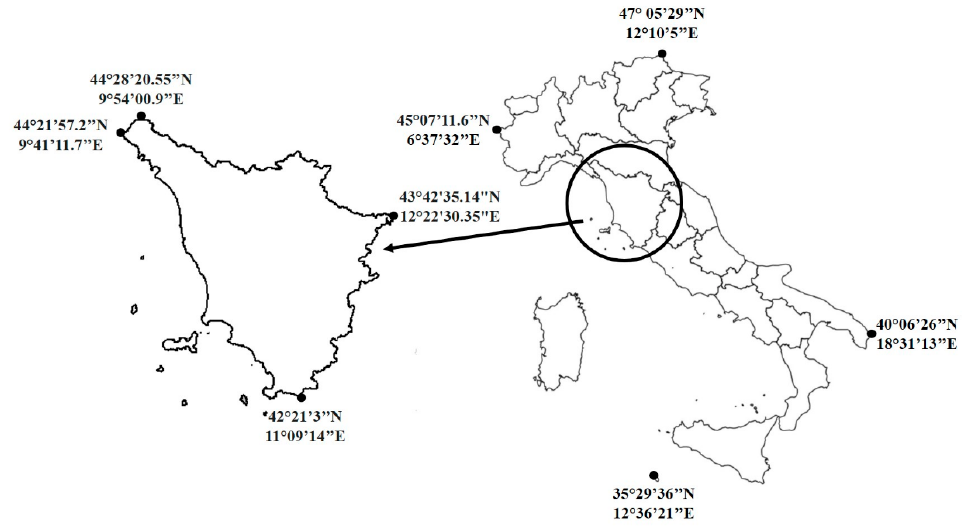
Figure 1. Study area: Tuscany region (Central Italy).